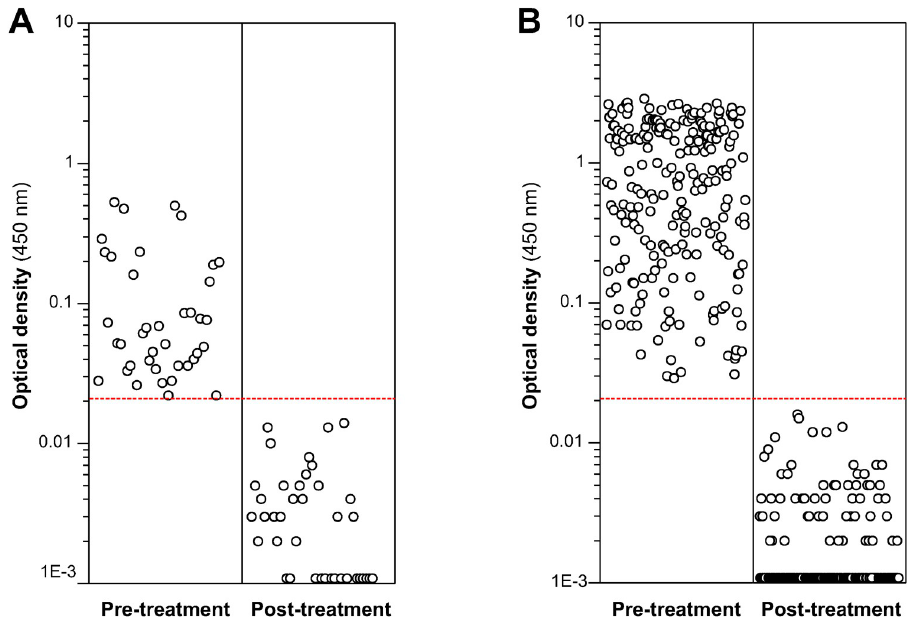
Fig 4. Effect of treatment with triclabendazole on the OD values of sheep testing positive by eMM3-COPRO test. The dose of triclabendazole was 10 mg/kg. Analyses were performed immediately before drug administration and 3 weeks post-treatment. Results are shown separately for sheep with negative (A) and positive (B) coprology. Dashed red line indicates the cut-off value (0.021).